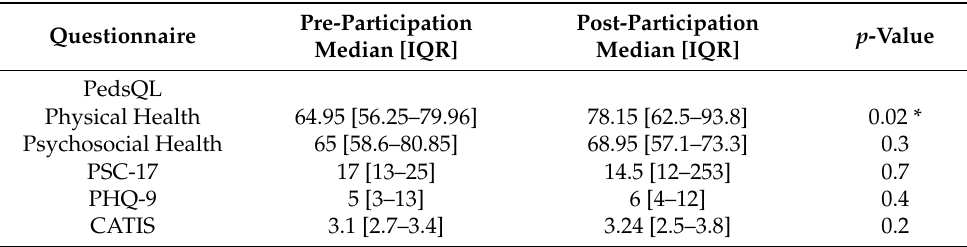
Table 1. Pre- and post-participation questionnaire medians, including p -values. * = Statistically